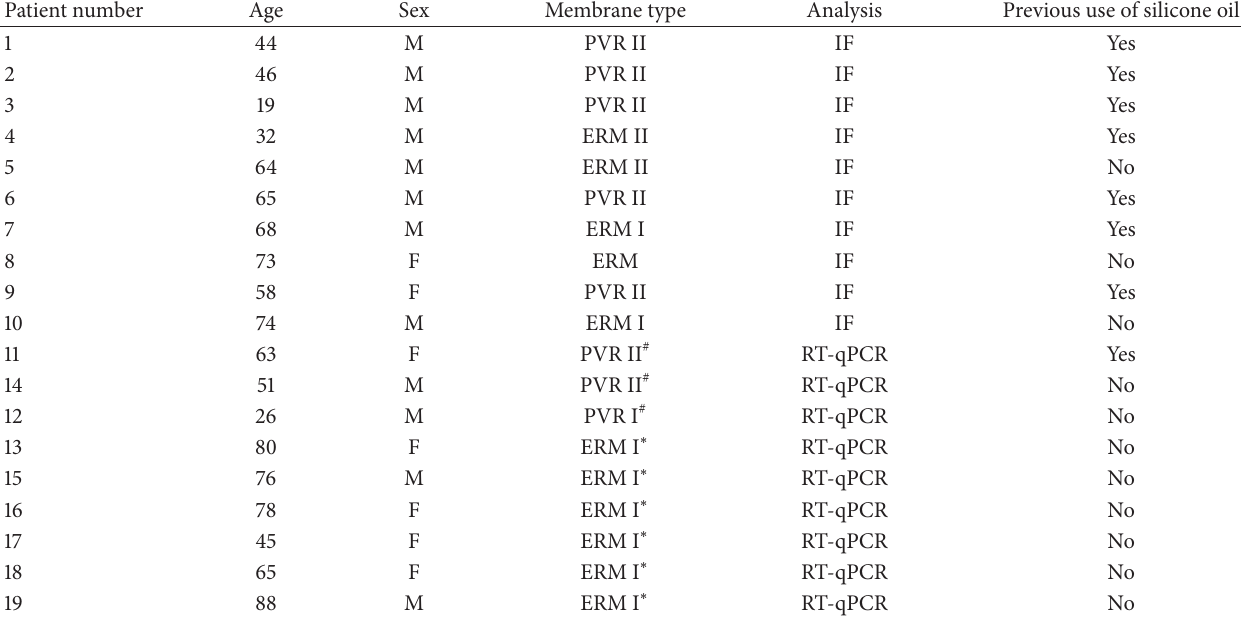
Table 1: Clinical data related to PVR and ERM